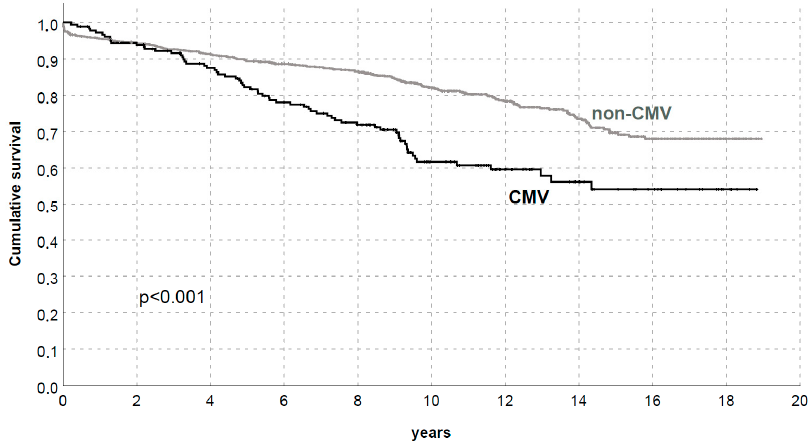
Figure 1. Death-censored graft survival by CMV replication/disease in the first year after transplantation.